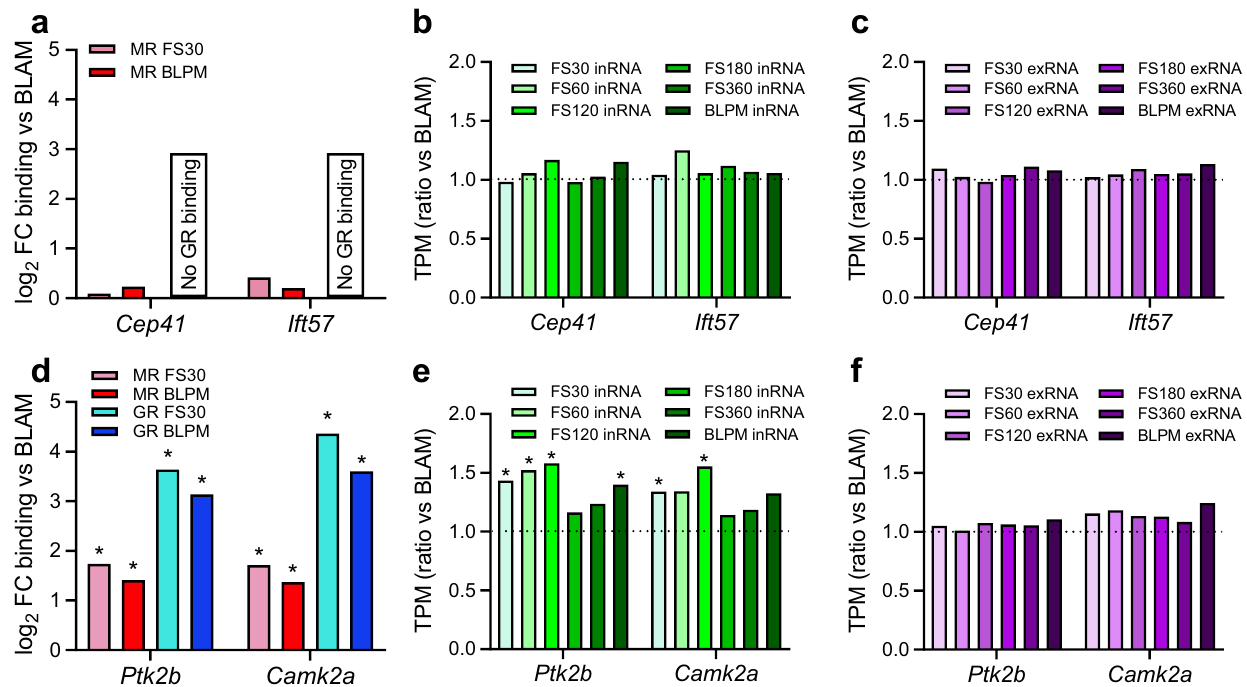
Fig. 8 Characterization of typical MR-only- and MR-&-GR-regulated genes involved in ciliary structure/function and neuroplasticity. Data were generated by MR/GR ChIP-seq and RiboZero RNA-seq analyses. Two genes associated with MR-only binding ( a – c ) or MR-&-GR-binding ( d – f ) are shown here which were selected for further investigation. a The fold changes in MR binding to Cep41 and Ift57 at FS30 and BLPM compared with BLAM levels are shown. No GR binding was detected in any of the 4 individual samples. Changes in intronic (inRNA, b ) and exonic (exRNA, c ) RNA levels of Cep41 and Ift57 are shown. Values are expressed as a ratio of transcripts per million (TPM) under BLAM conditions. There were no signi fi cant changes. The synaptic plasticity-related genes Ptk2b and Camk2a contain stress- and circadian-responsive MR and GR peaks. d The fold-changes in MR and GR binding at FS30 and BLPM compared with BLAM levels are shown. *FDR ≤ 0.05 (DiffBind). Changes in intronic (inRNA, e ) and exonic (exRNA, f ) RNA levels of Ptk2b and Camk2a are shown. Values are expressed as the ratio of transcripts per million (TPM) over BLAM levels. *FDR < 0.05 (EdgeR). Source data are provided in the Source Data